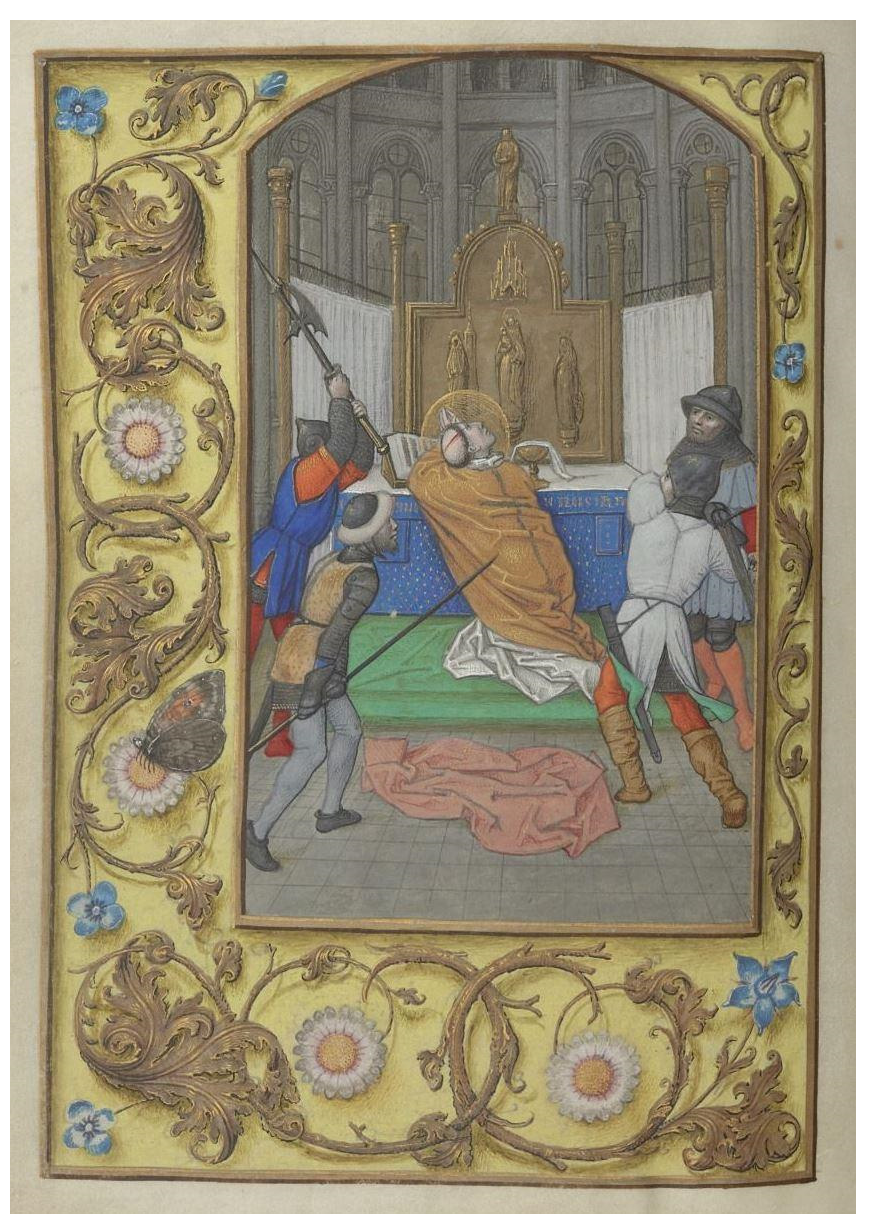
Figure 14. The martyrdom of Thomas Becket in the ‘Hastings Hours’ c. 1483. British Library, London, Add MS 54782 fo.55v .